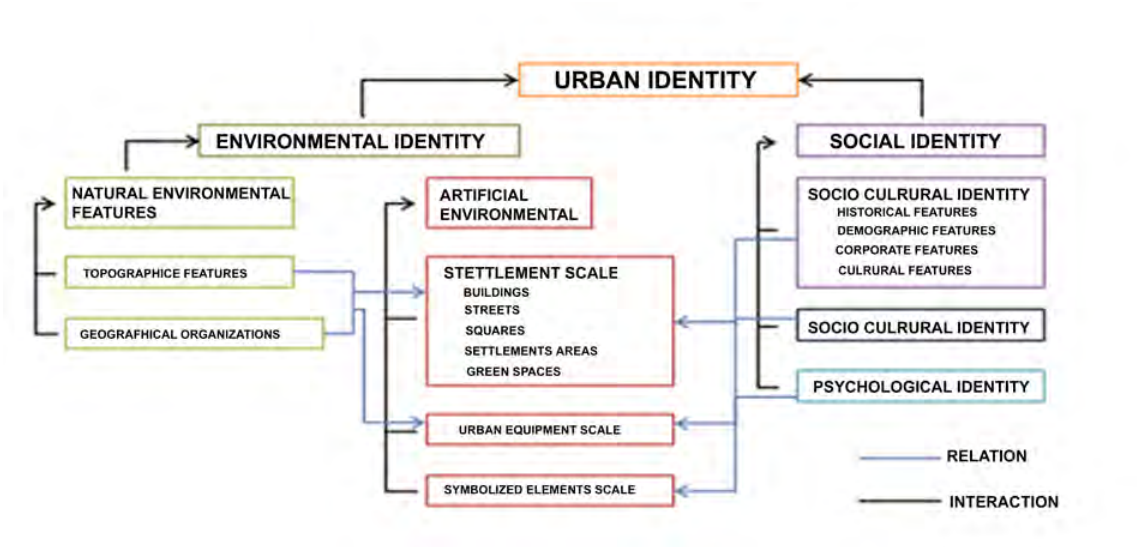
Figure 1. Urban Identity Components